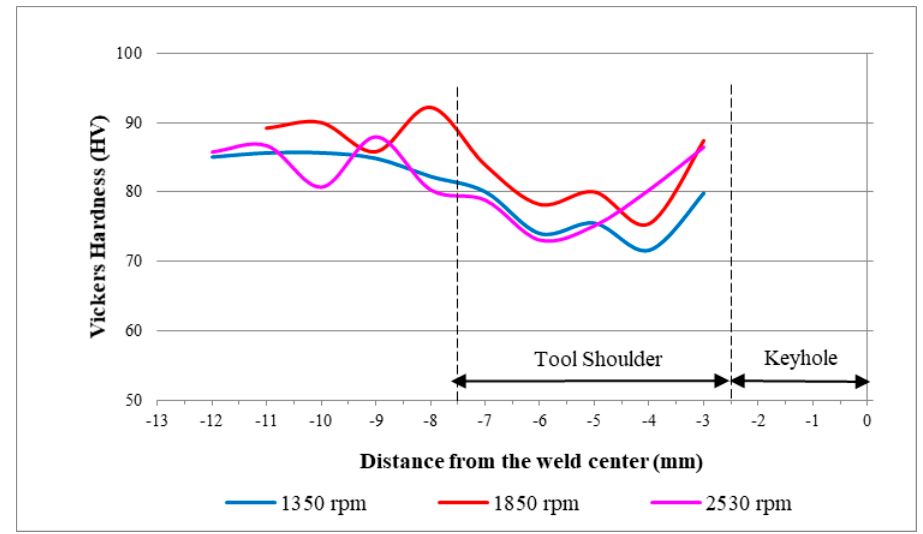
Figure 8. The Vickers hardness values of friction stir spot welding via the welding tool at three different rotational speeds.